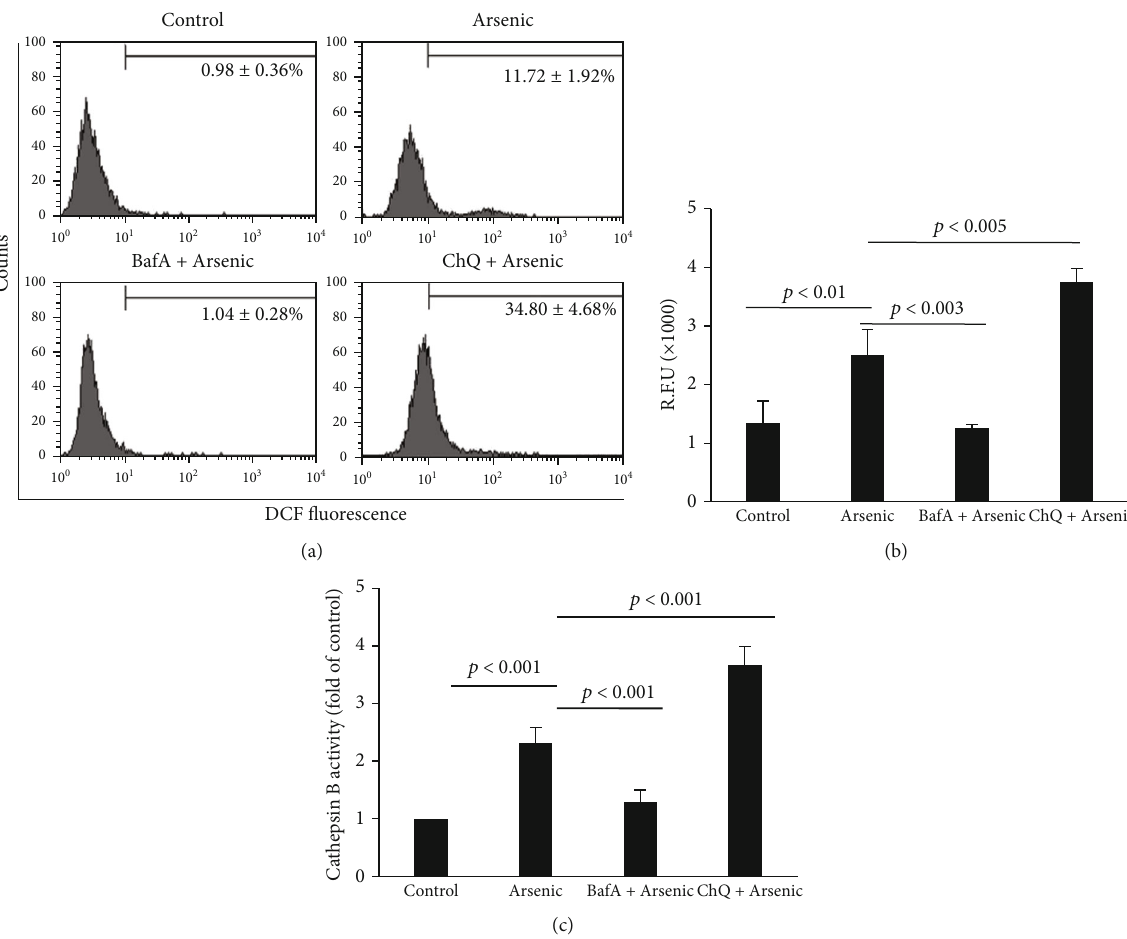
Figure 4: E ff ect of BafA and ChQ on arsenic-induced ROS formation and cathepsin B activity. (a) Representative fl ow cytometric analysis of arsenic induced ROS at 1 h using DCF-DA. (b) Quanti fi cation of ROS using multiplate reader at 1 h. The results indicate the mean ± SD of 6 independent experiments. (c) Cathepsin B activity from the cytosol of control and arsenic-exposed hepatocytes pretreated with or without BafA and ChQ. The results are representative of 6 identical